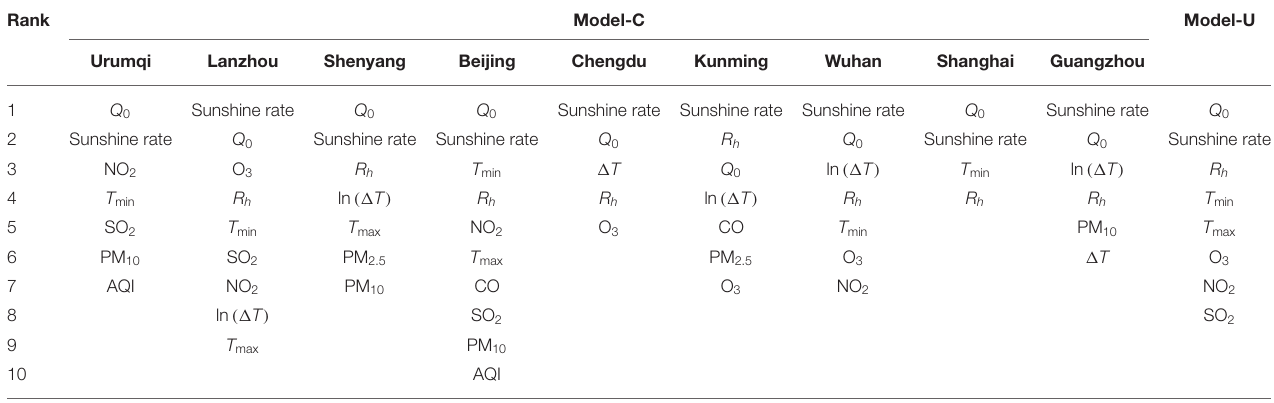
TABLE 1 | Elements of the city models and ranking of their contributions.